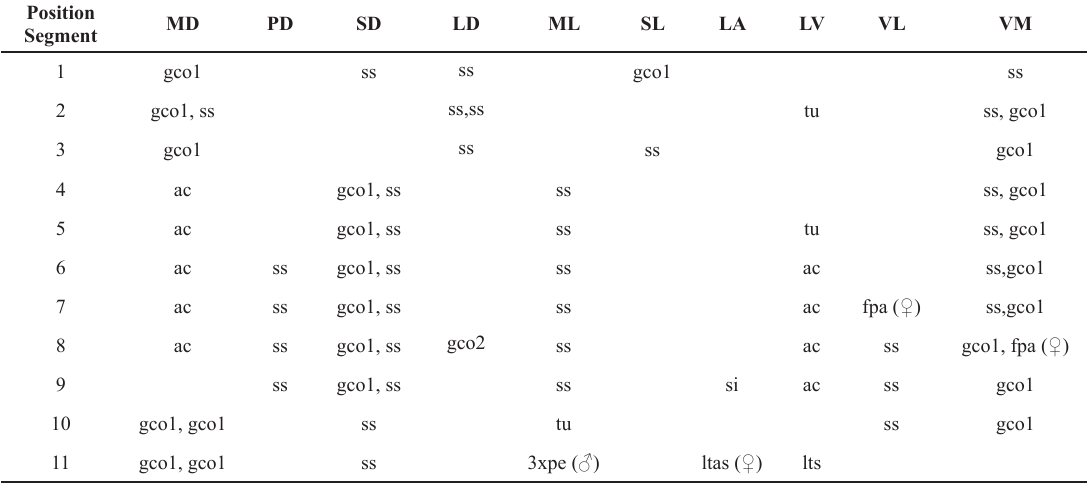
Table 8. Summary of nature and location of sensory spots, glandular cell outlets, tubes and spines arranged by series in Echinoderes pacificus Schmidt, 1974. Note that mapping of sensory spots might be